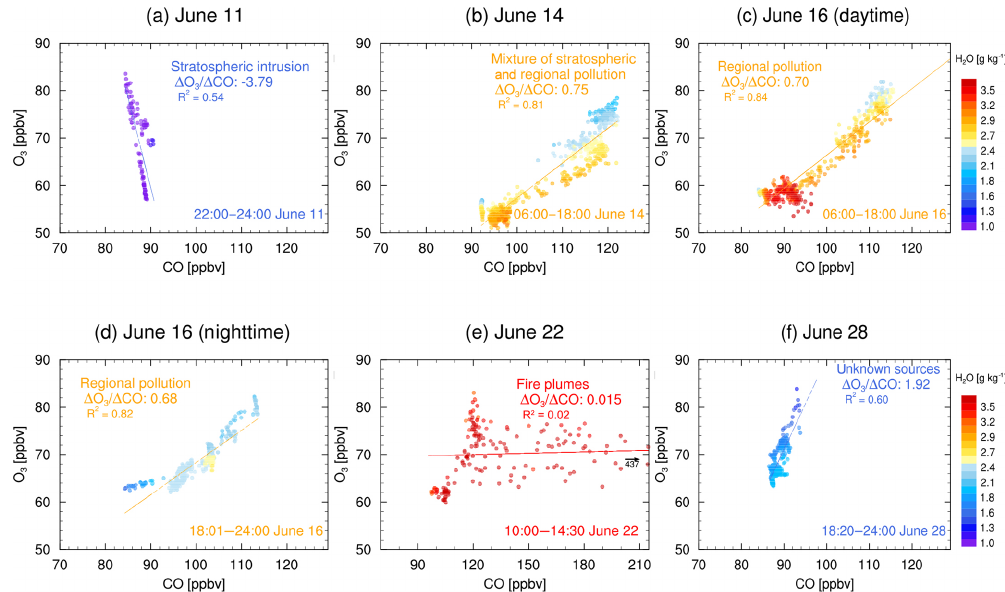
Figure 6. Scatterplots of 1min average O 3 against CO measured at Angel Peak, color-coded by specific humidity, for air masses influenced by (a) STT on 11 June; (b) regional pollution on 14 June; (c–d) regional pollution plume during daytime (06:00–18:00) and nighttime (18:01–24:00) on 16 June; (e) wildfires on 22 June; and (f) unattributed pollution on 28 June. Note that peak CO mixing ratios on 22 June were 440ppbv (not shown on the